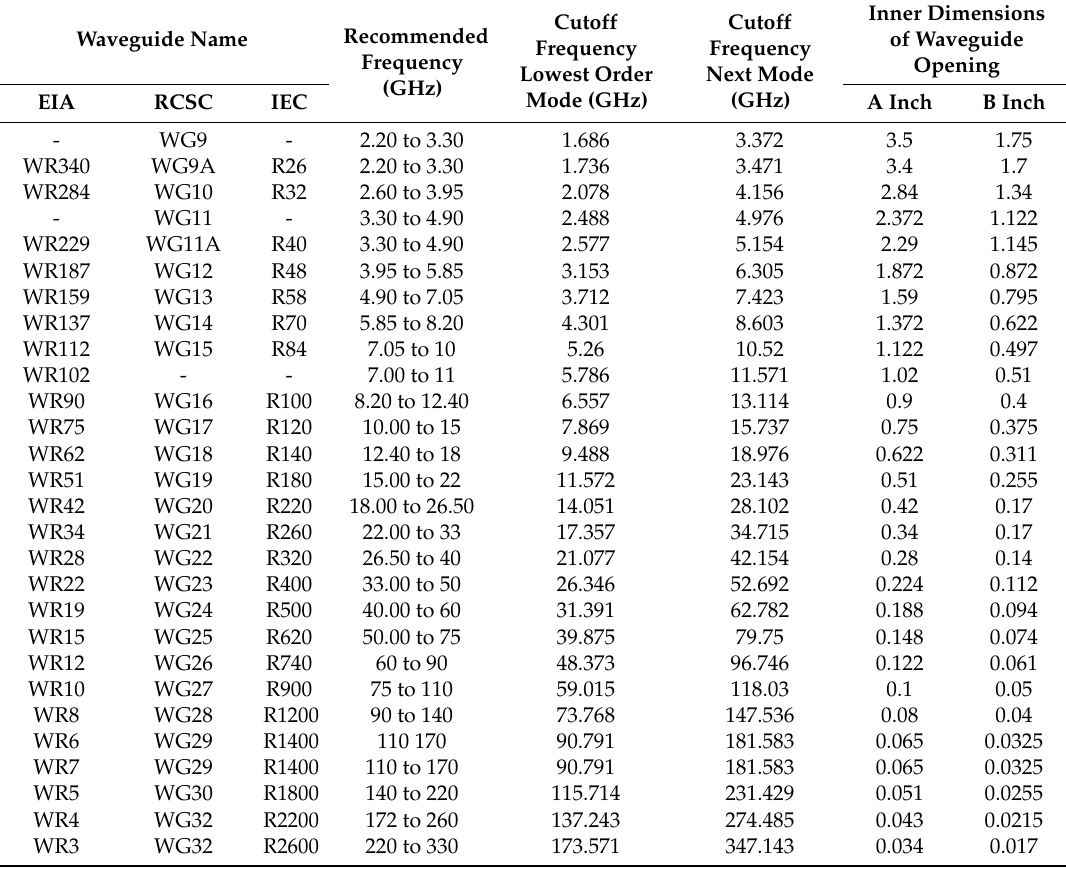
Table 1. Rectangular waveguide sizes (source: https://www.everythingrf.com/tech-resources/